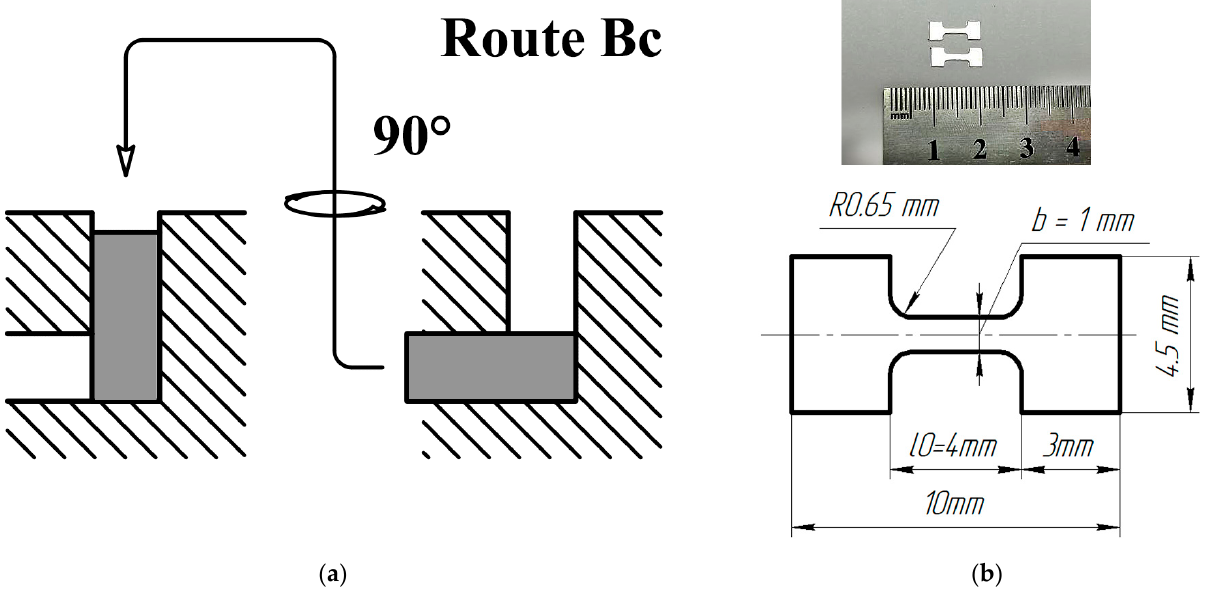
Figure 1. Schematic representation of ECAP process according to route Bc ( a ); miniature tensile specimen design: a general view at the top and specimen layout at the bottom ( b ).